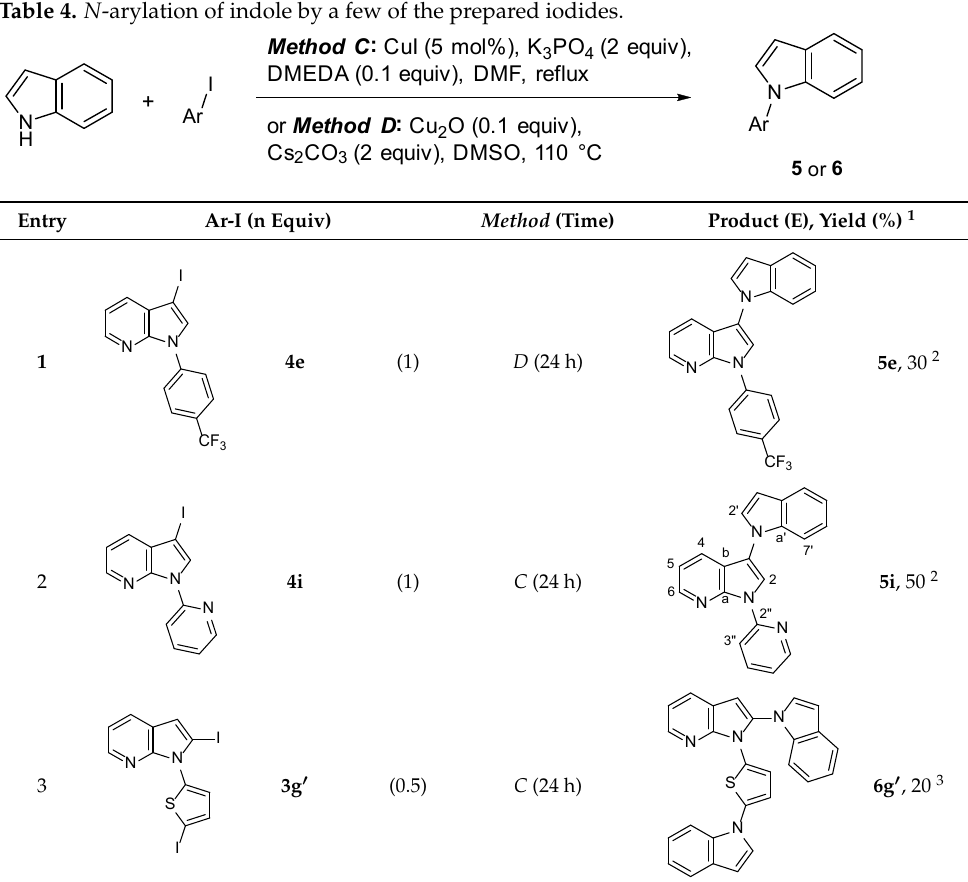
Table 4. N -arylation of indole by a few of the prepared iodides.